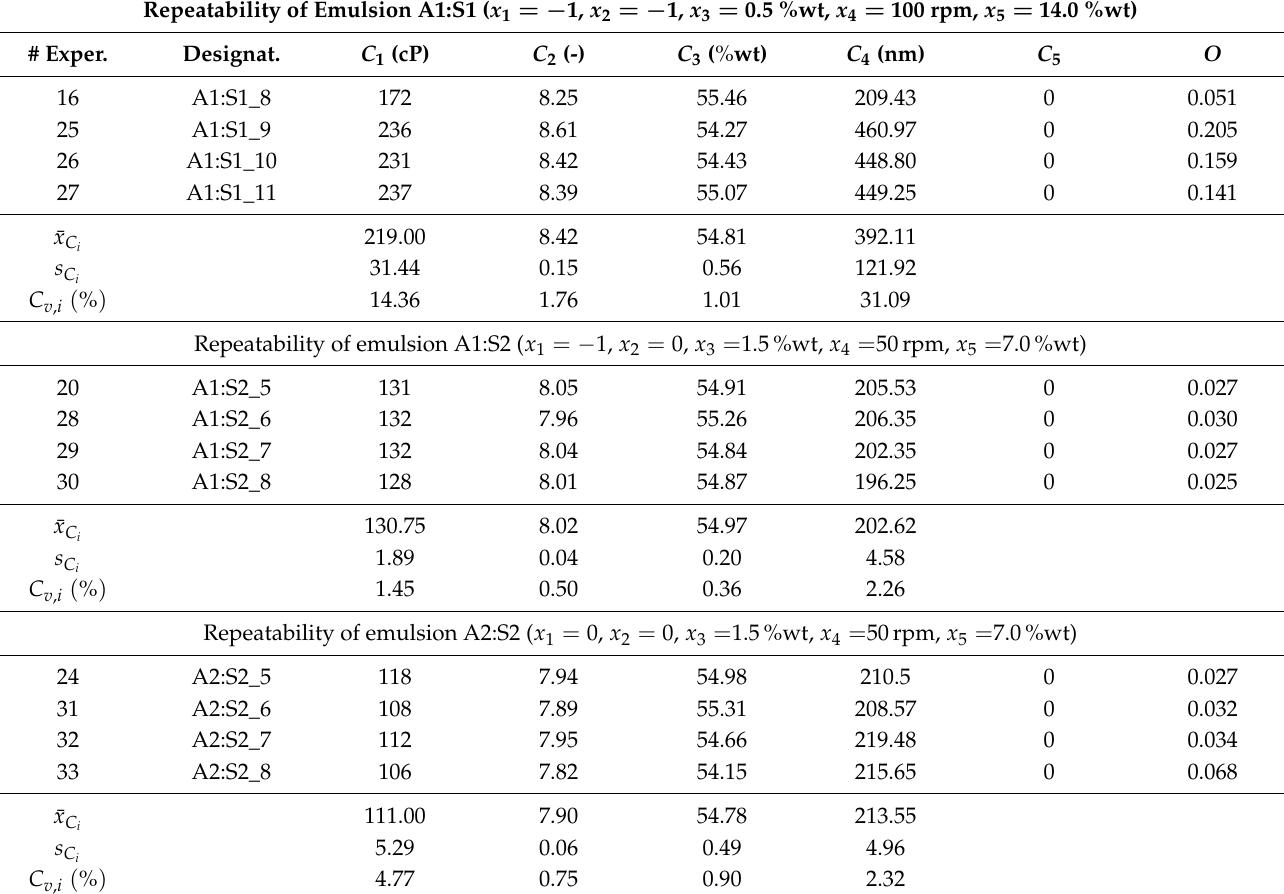
Table 8. Results of the experimental design in Stage